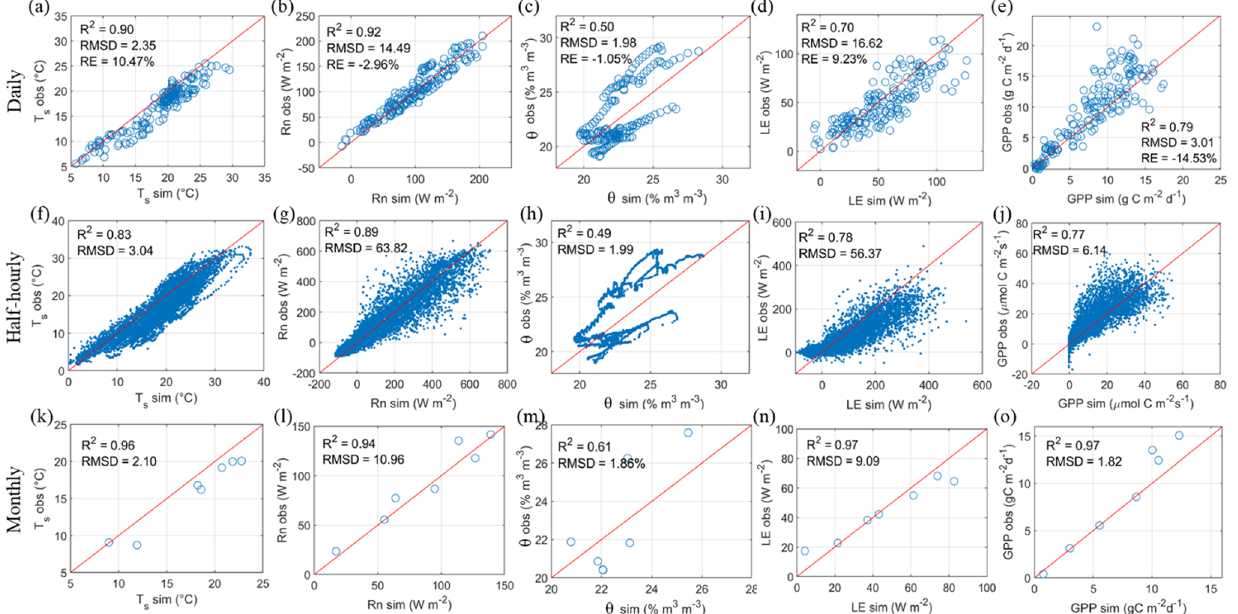
Figure 8. Validation of the interpolated land surface variables at daily, half-hourly, and monthly timescales at the willow plantation: panels (a–e) show the daily scale, (f–j) show the half-hourly scale, and (k–o) show the monthly scale. Panels (a) , (f) , and (k) show the surface temperature ( T s ); (b) , (g) , and (l) show the net radiation ( R n ); (c) , (h) , and (m) show the soil moisture ( θ ); (d) , (i) , and (m) show the latent heat flux ( LE ); and (e) , (j) , and (o) show the gross primary productivity (GPP). The RE metrics for the half-hourly and monthly scales are not shown, as they are the same as the RE at the daily